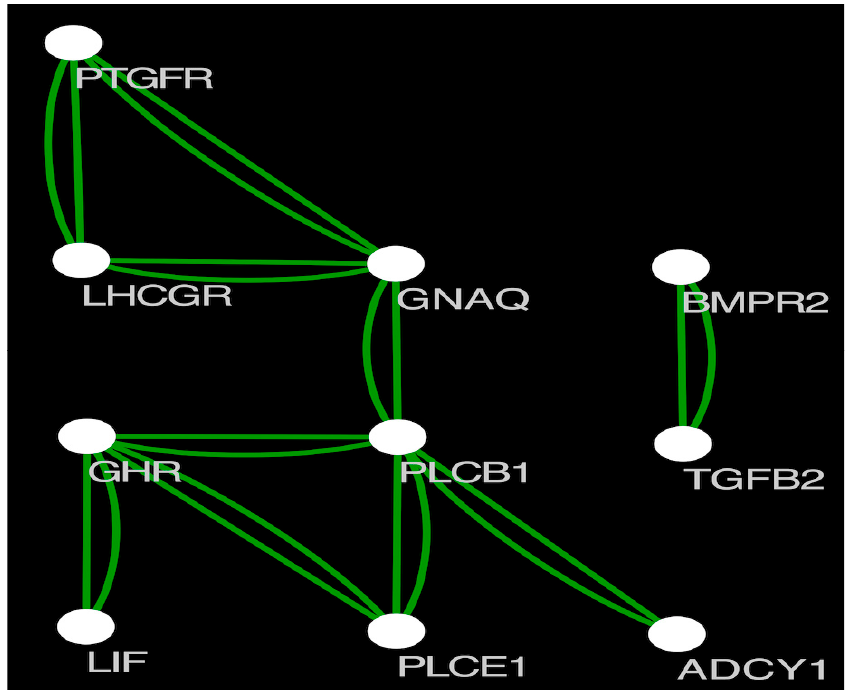
Figure 3. ( A ): The area above the dotted line includes Hetian sheep/Cele Black sheep are subject to selection. ( B ): The area above the dotted line includes Cele Black sheep/Hetian sheep subject to se- lection.